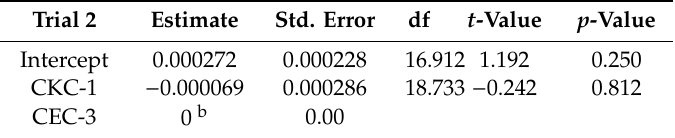
Table 18. The significant di ff erence of the mean of VR obtained in Trial 2 between CKC-1 and CEC-3. Trial 2 Estimate Std. Error df t -Value p -Value Intercept 0.000272 0.000228 16.912